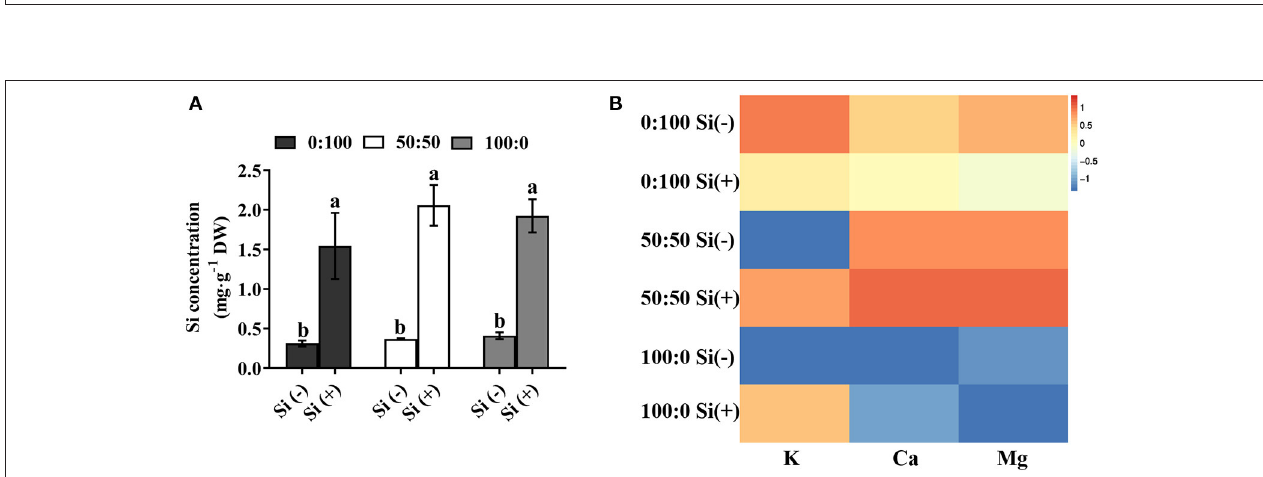
FIGURE 3 | (A) Growth analysis and (B) ammonium toxicity appearance ratio (%) of cabbage plants in response to 100% NH + 4 without Si (–) and with Si ( + ). Data in (B) are the means of 120 plants underpinning 6 independent replicates ± SD from different treatment groups; *** P < 0.001 was calculated by Student’s two-sided t -test. Plants with identical treatments showed similar growth and the representative one was selected for photographing. Red arrows point to the typical NH + 4 toxicity symptoms. Scale bar in (A) represents 2cm.